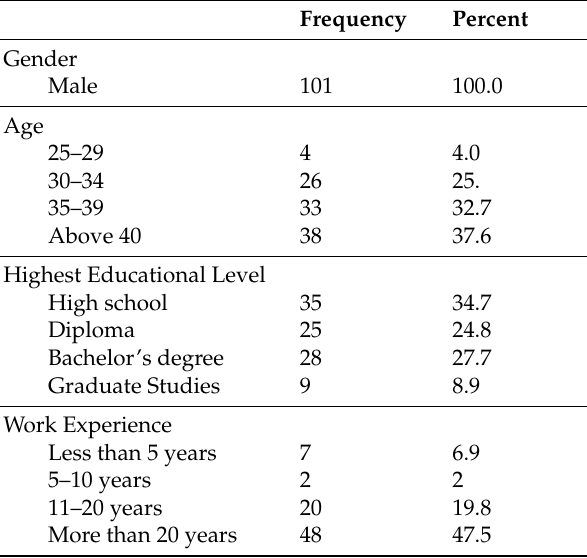
Table 1. Demographic Profile of the Total